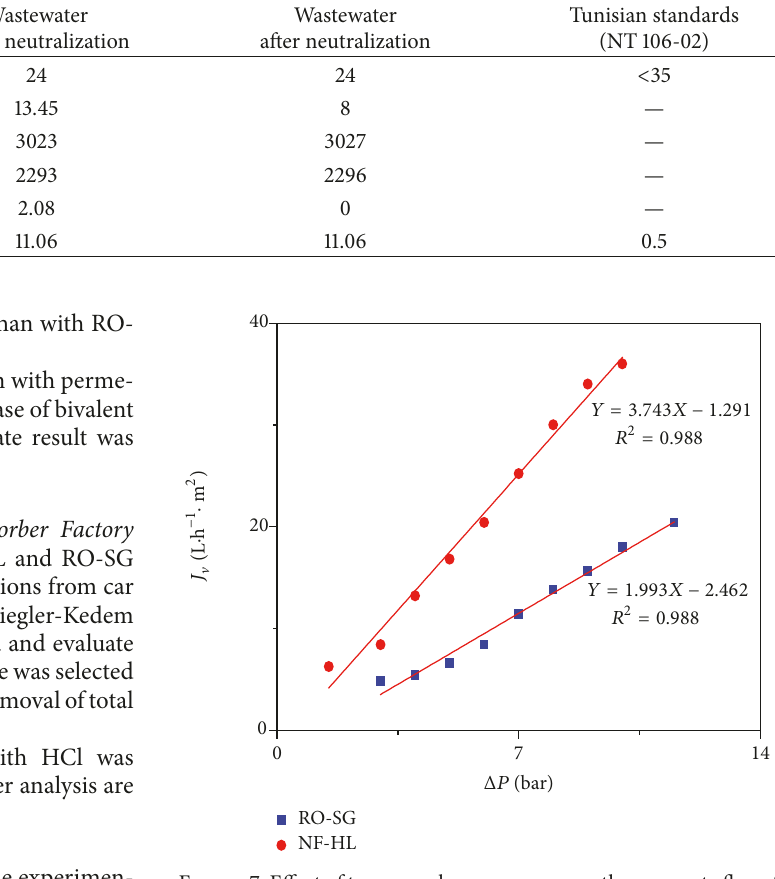
Figure 7: Effect of transmembrane pressure on the permeate flux of